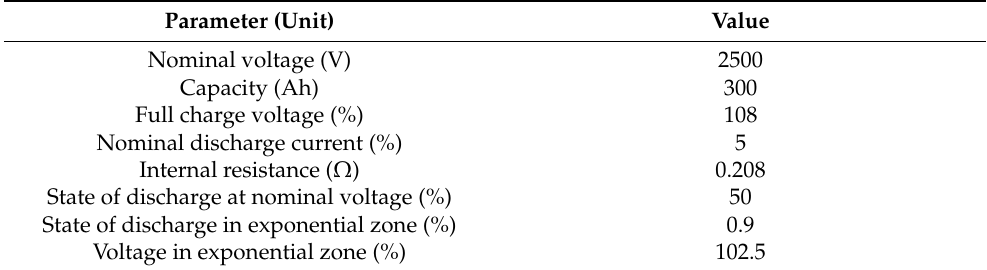
Table 2. Parameters of the